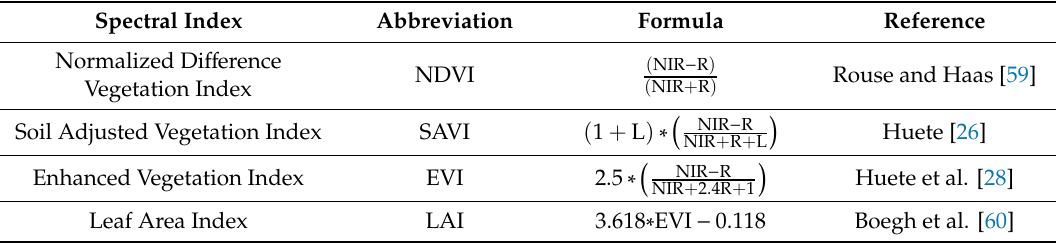
Table 1. Satellite-derived vegetation indices used in the